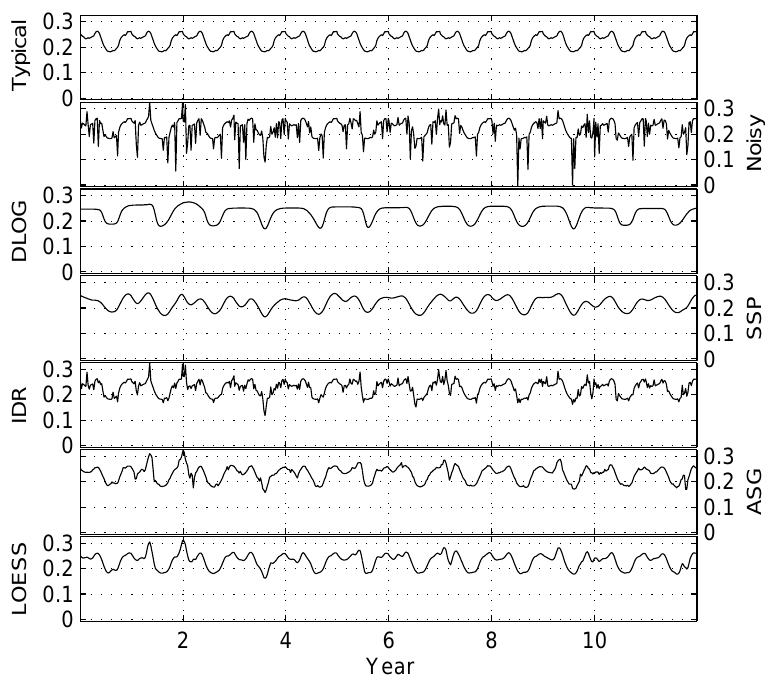
Figure 2. Reconstructed fAPAR series corresponding to a mosaic of croplands area. The original fAPAR ( top ) is followed by the noisiest scenario with N ( μ = − 0.05, σ = 0.05) in 25% of the points and the four filtered signatures.